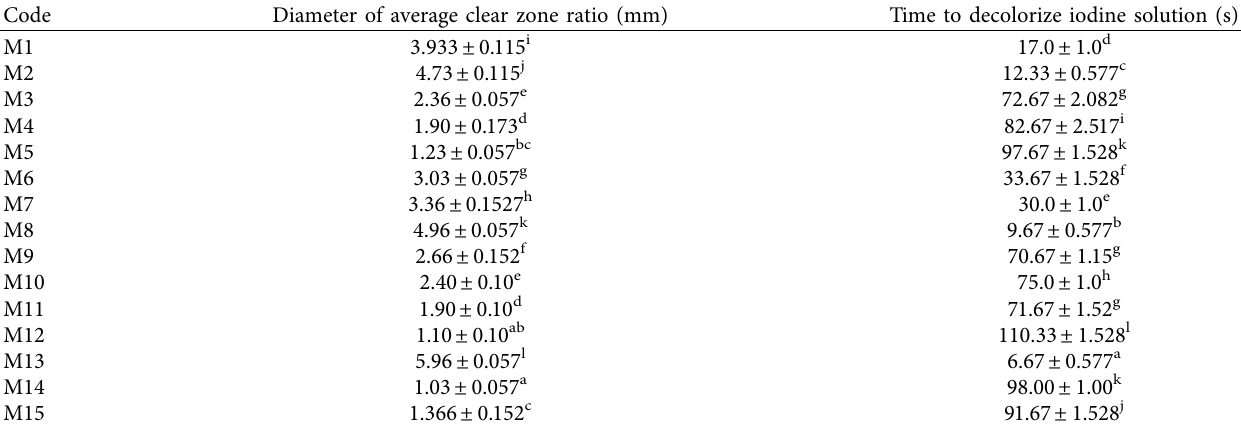
Table 1: Diameter of average clear zone ratio formed by selected bacteria and the time taken to decolorize iodine solution. Code